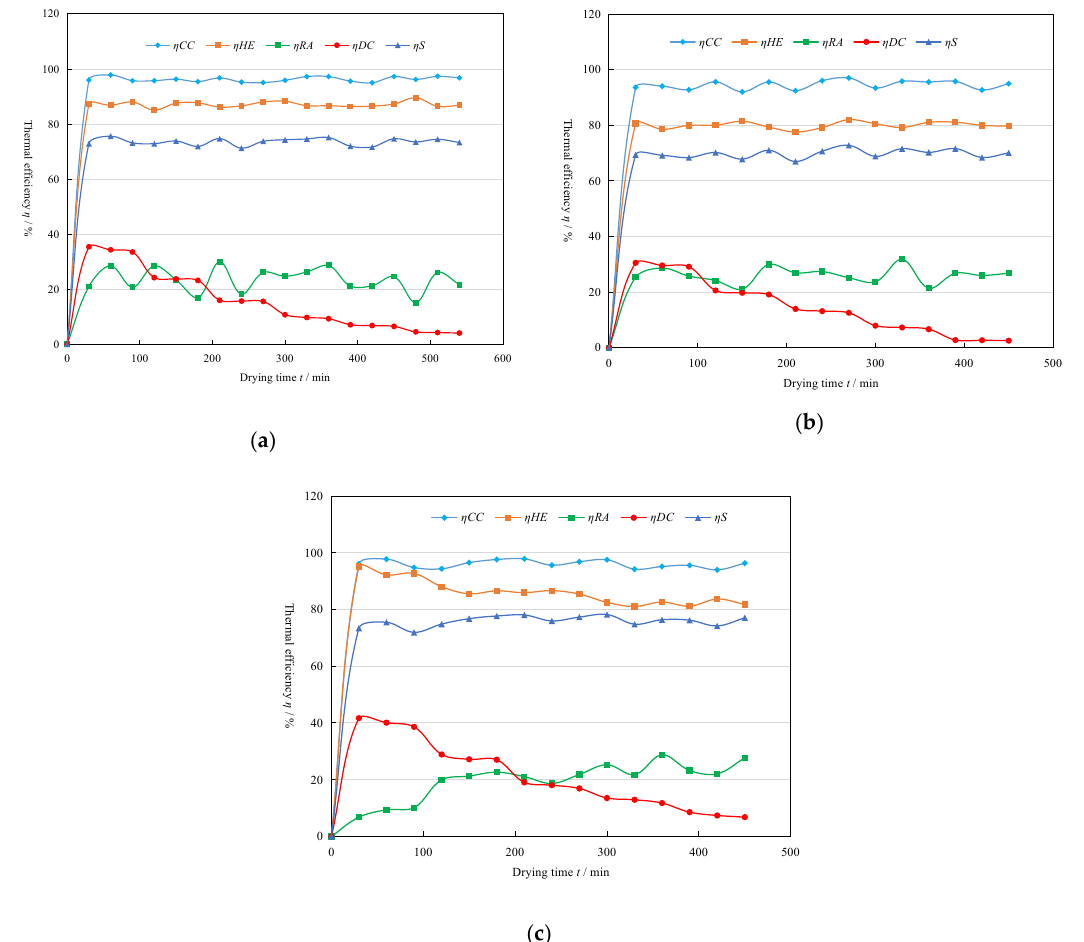
Figure 7. The thermal efficiency of the key components for the drying process of α = 75°( a ), α = 90°( b ) and the optimized drying process ( c ).